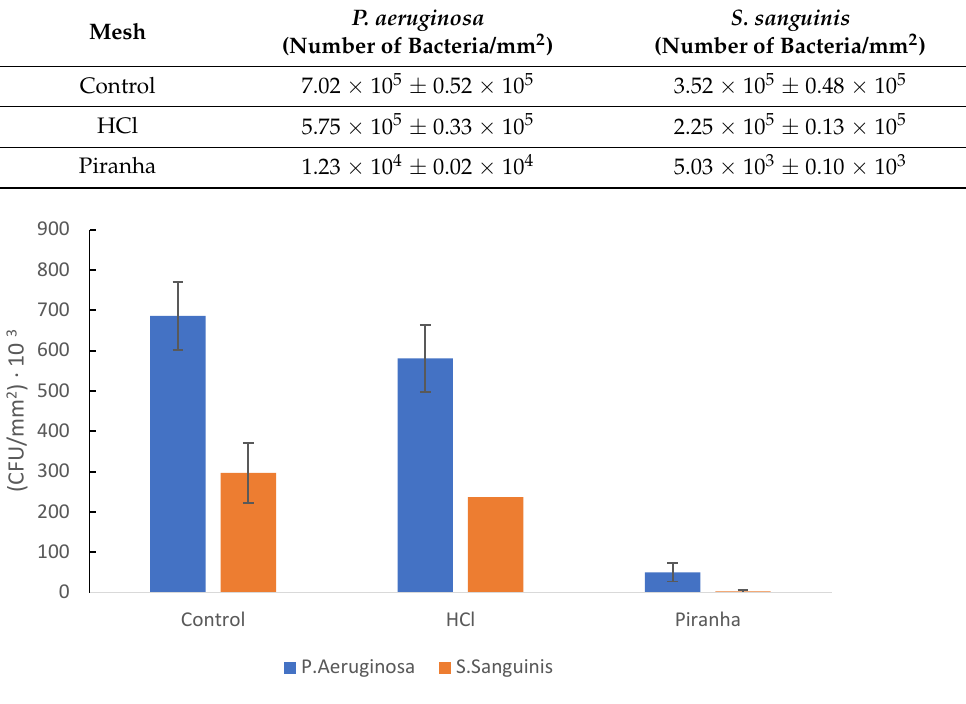
Figure 10. SEM ( top row ) and fluorescence ( bottom row ) images of P. aeruginosa stained by LIVE/DEAD.